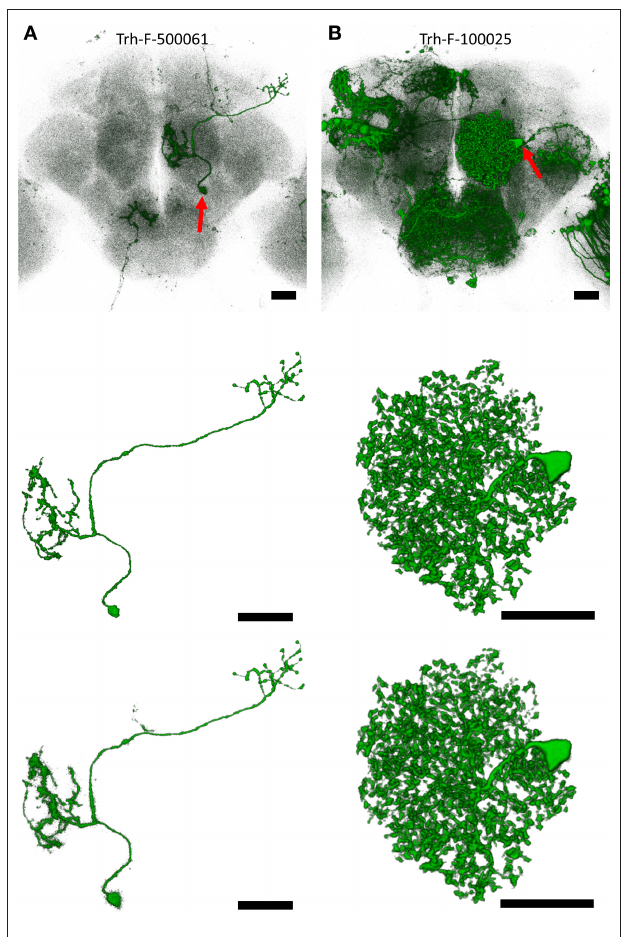
FIGURE 3 | Examples of single neurons segmented by NR vs. human. (A) An olfactory projection neuron (Trh-F-500061) linking the antennal lobe and lateral horn. (B) A local interneuron (Trh-F-100025) within the antennal lobe. Upper row: raw images, middle row: human-segmented neurons, lower row: NR -segmented neurons. Red arrows indicate soma. Scale bars represent 25 µ